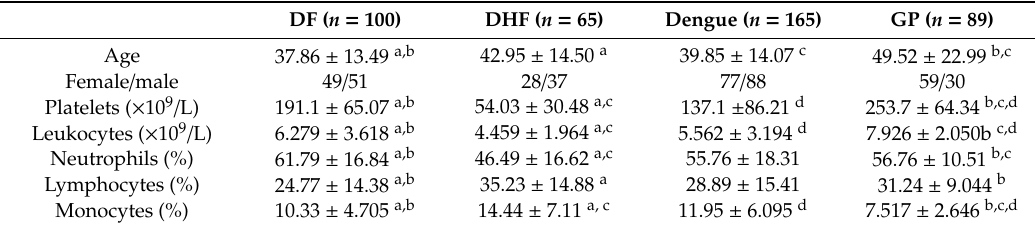
Table 1. Hematological values of the individuals with dengue fever (DF) and dengue hemorrhagic fever (DHF), and general population (GP). DF ( n =